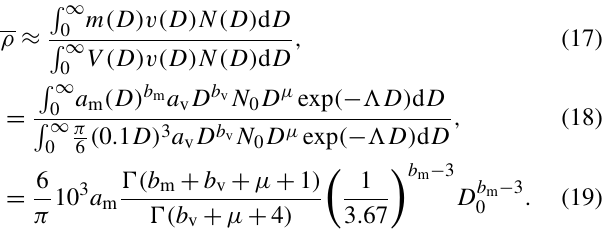
Figure 11. ( D 0 , ρ ) for all cases listed in Table 1. Area of each dot is proportional to the number of particles in corresponding integra- tion time interval. Power-law fits are shown separately for BAECC winter cases (blue) and cases from the following winter